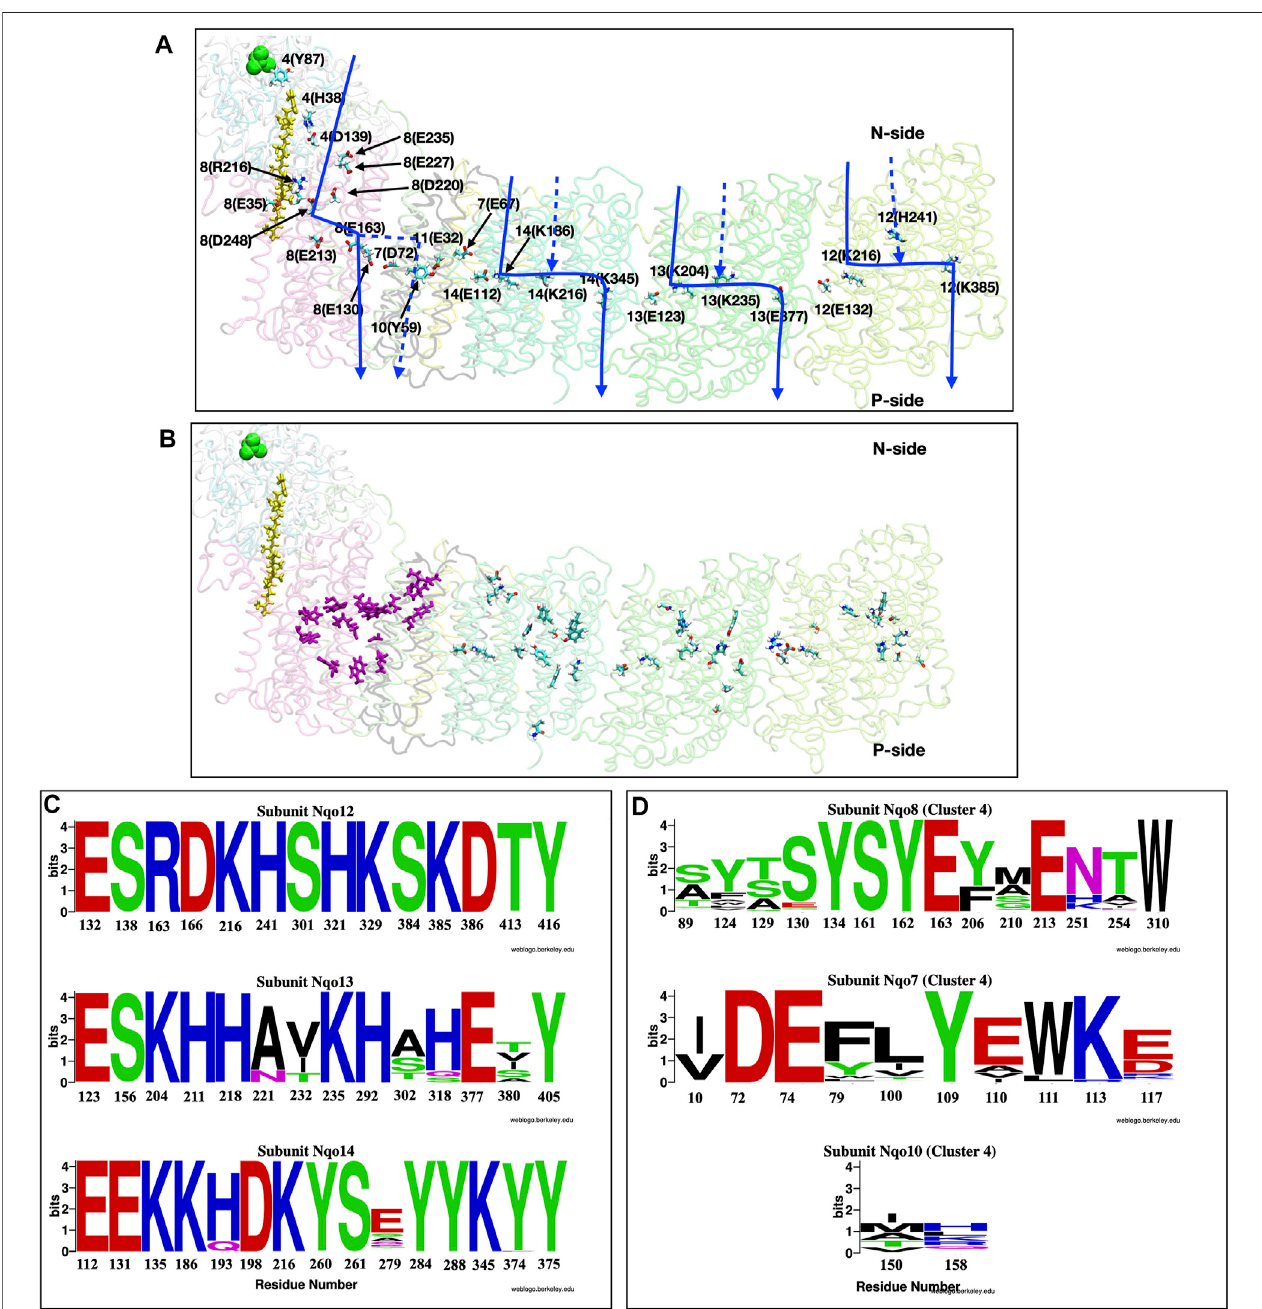
FIGURE 8 | (A,B) Structure of the full membrane domain of complex I and only the Nqo4 subunit of the periplasmic domain from T. thermophilus [PDB ID: 4HEA (Baradaranetal.,2013)]highlightingprotontransferpaths. (A) Residuesthathavebeenproposedtobeimportantforprotonpumpingareshownassticksandlabeledas subunit number (one letter amino acid designation-residue number). Quinone is yellow and N2 of each Iron Sulfur cluster is green. Approximate locations of putative protontransferpathsarebluearrowsanddashedlinesshowalternative,proposedpaths. (B) Residuesthatareincludedintheconservationanalysis.Purplesticks: E channel cluster in the center of the protein [Cluster 4 in (Khaniya et al., 2020)]; Sticks colored by atom type: antiporter residues (Baradaran et al., 2013; Di Luca et al., 2017; Haapanen and Sharma, 2017; Gutiérrez-Fernández et al., 2020). (C,D) Conservation analysis shown as Weblogo (Crooks, 2004) representation of multiple sequence alignment of 1,000 complex I sequences (Johnson et al., 2008; Sievers et al., 2011). (C) Residues in the three linear antiporter pathways in Nqo12 (Top) , Nqo13 (Middle) and Nqo14 (Bottom) subunits. (D) Residues in the E-channel cluster 4. Residues from Nqo8 (Top) , Nqo7 (Middle) and Nqo10 (Bottom) .